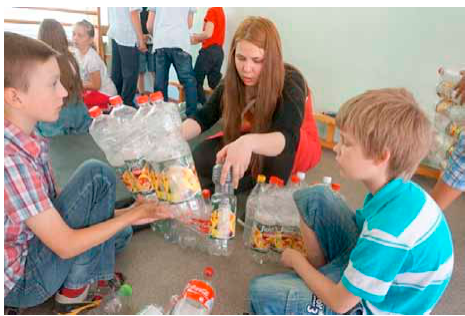
Fig. 4. Preparing an ant installation from used bottles (Elena Sakalauskaitė’s